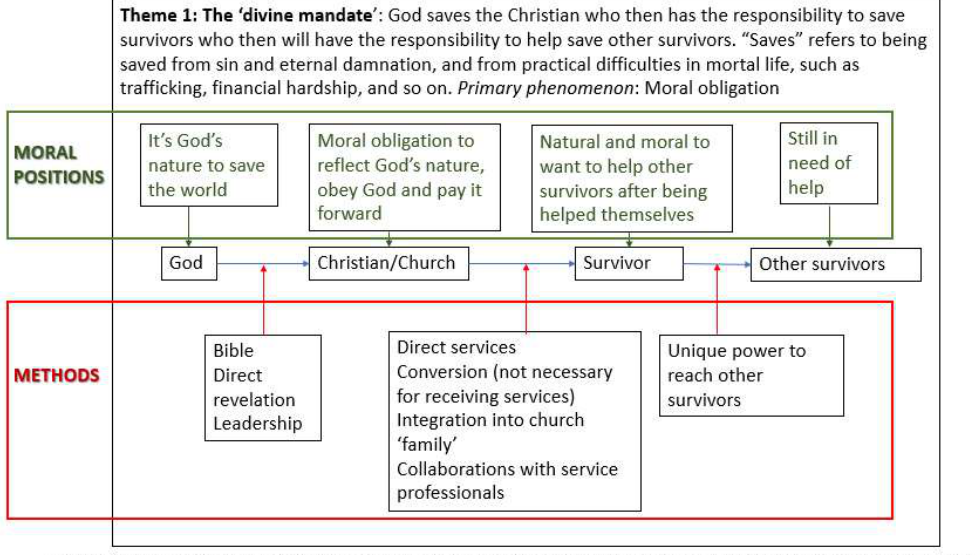
Figure 1. Illustration of the Divine